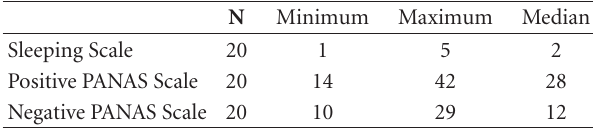
Table 1: Median values for age, sleeping scale and PANAS scale. N Minimum Maximum Median Sleeping Scale 20 1 2 Positive PANAS Scale 20 14 42 28 Negative PANAS Scale 20 10 29